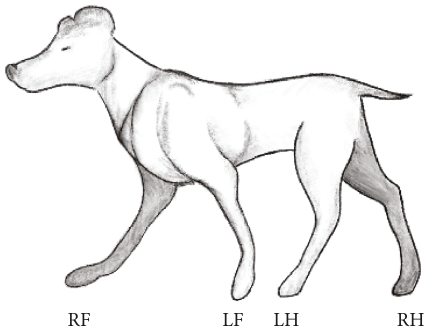
Figure 9: The label has four